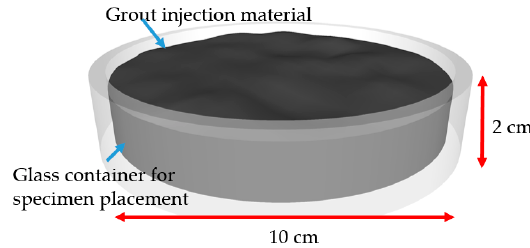
Figure 5. The specimen for chemical exposure resistance and water flow erosion resistance testing.